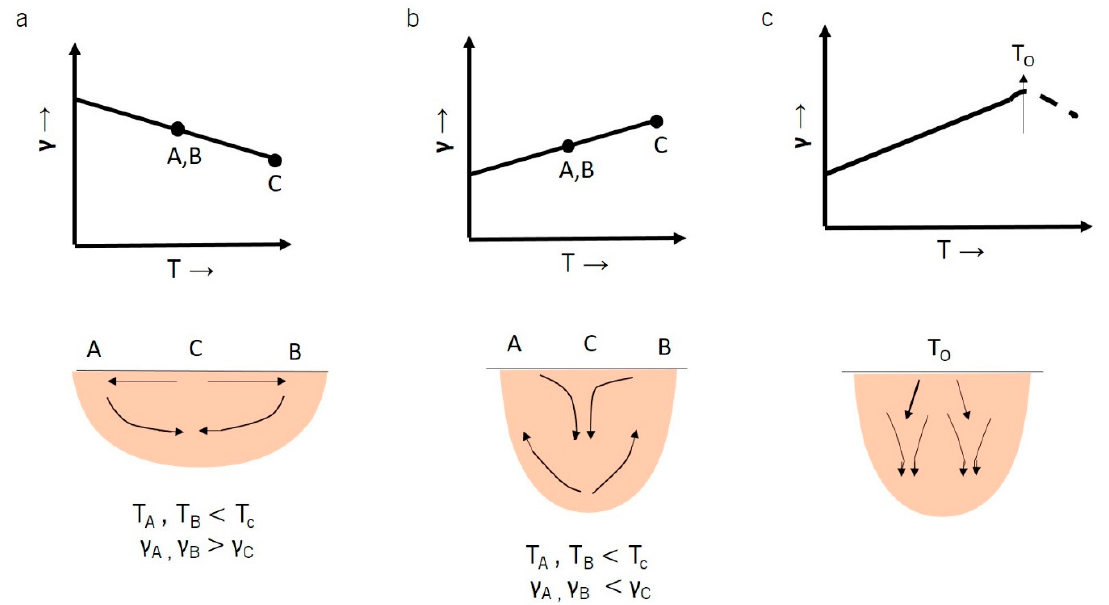
Figure 3. Schematic of Marangoni e ff ect using the Heiple–Roper theory of weld pool geometry, depending on the surface tension and temperature of the melt pool, as applicable for DED systems. ( a ) Melt pool geometry when the surface tension gradient is negative, ( b ) melt pool geometry when the surface tension gradient is positive, and ( c ) melt pool geometry when the surface tension gradient shifts from positive to negative.